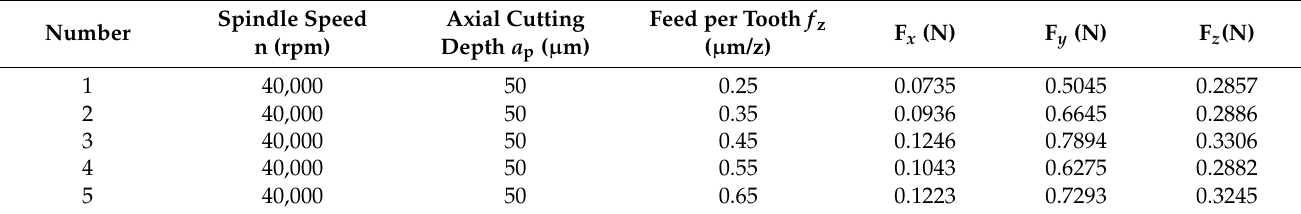
Table 6. Experiments for determining the minimum cutting